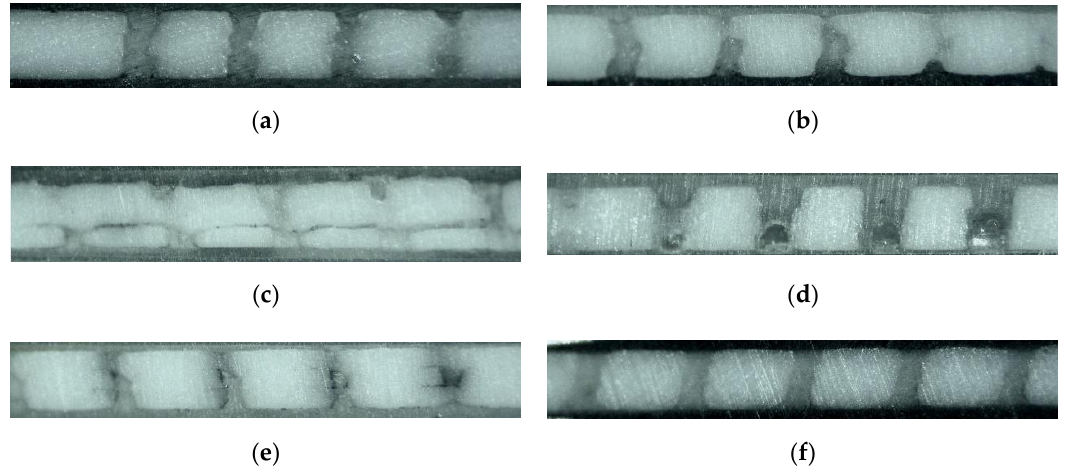
Figure 8. Cross-sections of the samples, after firing: ( a ) HEC 2 wt% hole structure, ( b ) HEC 5 wt% hole structure, ( c ) agar-agar hole structure ( d ) gelatin hole structure, ( e ) carbon paste hole structure and ( f ) no SVM hole structure. The hole structures as presented in these figures are not of the same hole size.